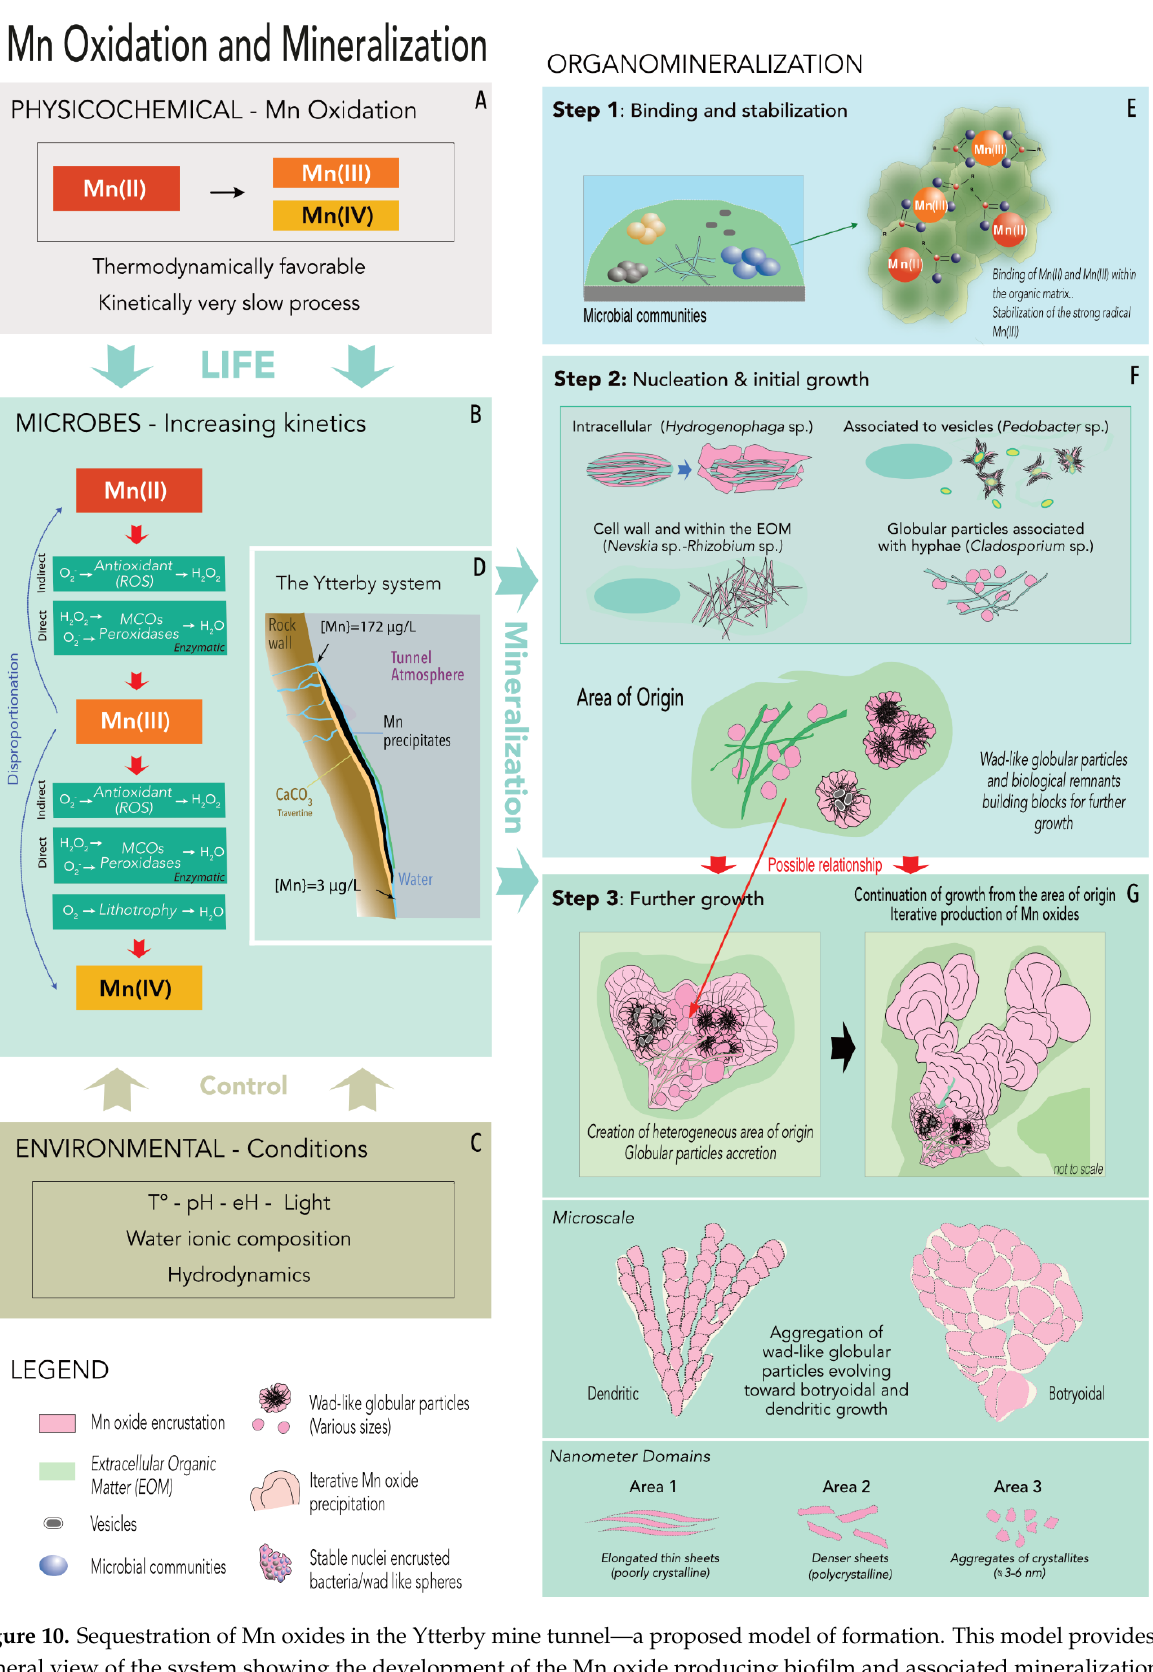
Figure 10. Sequestration of Mn oxides in the Ytterby mine tunnel—a proposed model of formation. This model provides a general view of the system showing the development of the Mn oxide producing biofilm and associated mineralizations. See Section 4.6 for a detailed description.